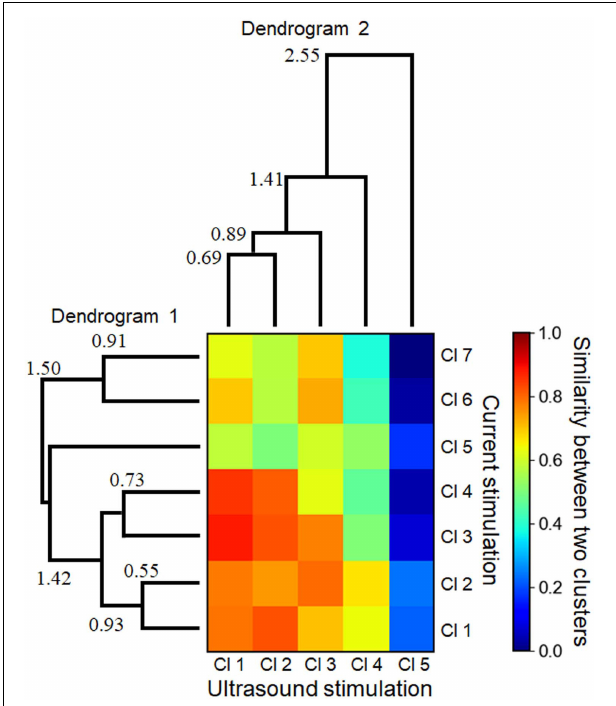
FIGURE 11 | Similarities between two cluster sets with respect to the response patterns driven by electrical and ultrasound stimulations. A heatmap shows the normalized similarity between the two cluster sets. To calculate the similarity of the values in the heat map, Euclidean distances between the centroids of the individual clusters were calculated, and the similarity values were found to be inversely proportional to the distances. Two dendrograms (linkage tree diagrams) illustrate the cluster sets for the electrical stimulation (dendrogram 1) and ultrasound stimulation (dendrogram 2). The numbers in the dendrograms represent the corresponding distance values between the linked clusters. The minimum values (0.55 and 0.69 in dendrograms 1 and 2, respectively) were over the preset threshold ( > 0.5).